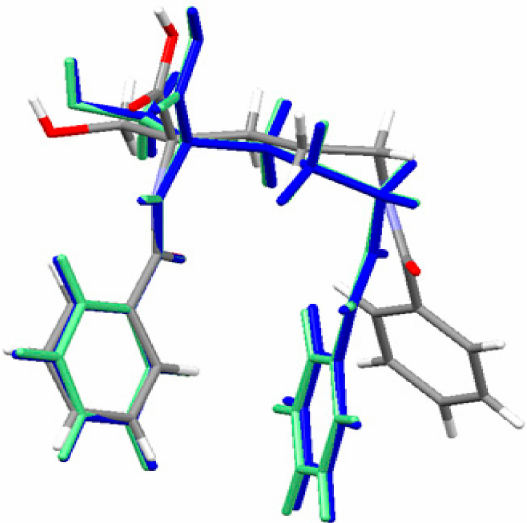
Figure 3. Superposition of the X-ray structure of ornithine derivative 1 and the M06 optimized ornithine derivative 1 in gas-phase (blue) and solvated state (light green). Experimental X-ray structure is colored by